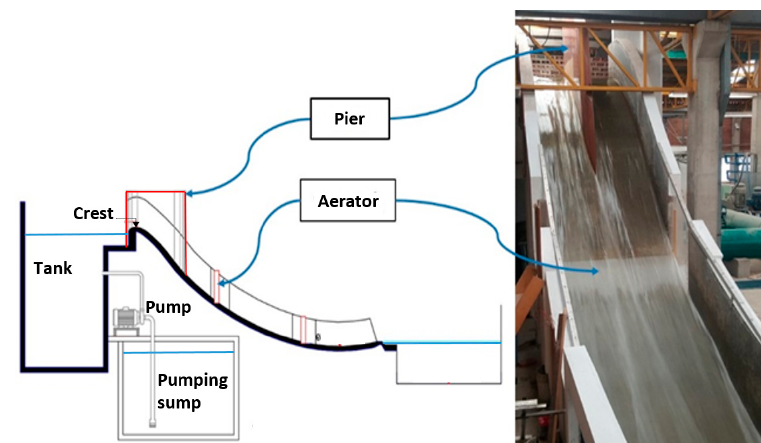
Figure 2. Physical model of the Huites Dam spillway.